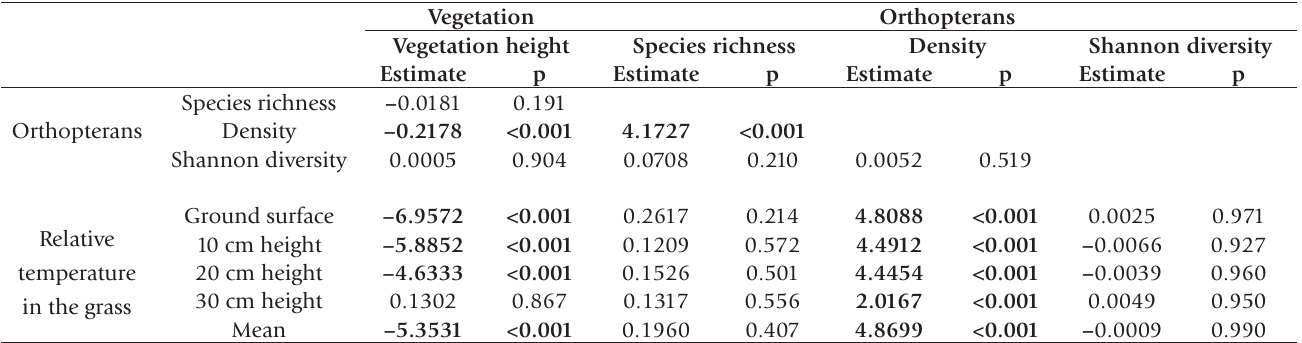
Table 1. Results of generalized linear model (Poisson distribution) of species richness, density and Shannon diversity of orthopterans in relation to vegetation height, relative temperature in the vegetation (June, July, August)(significant values in bold).